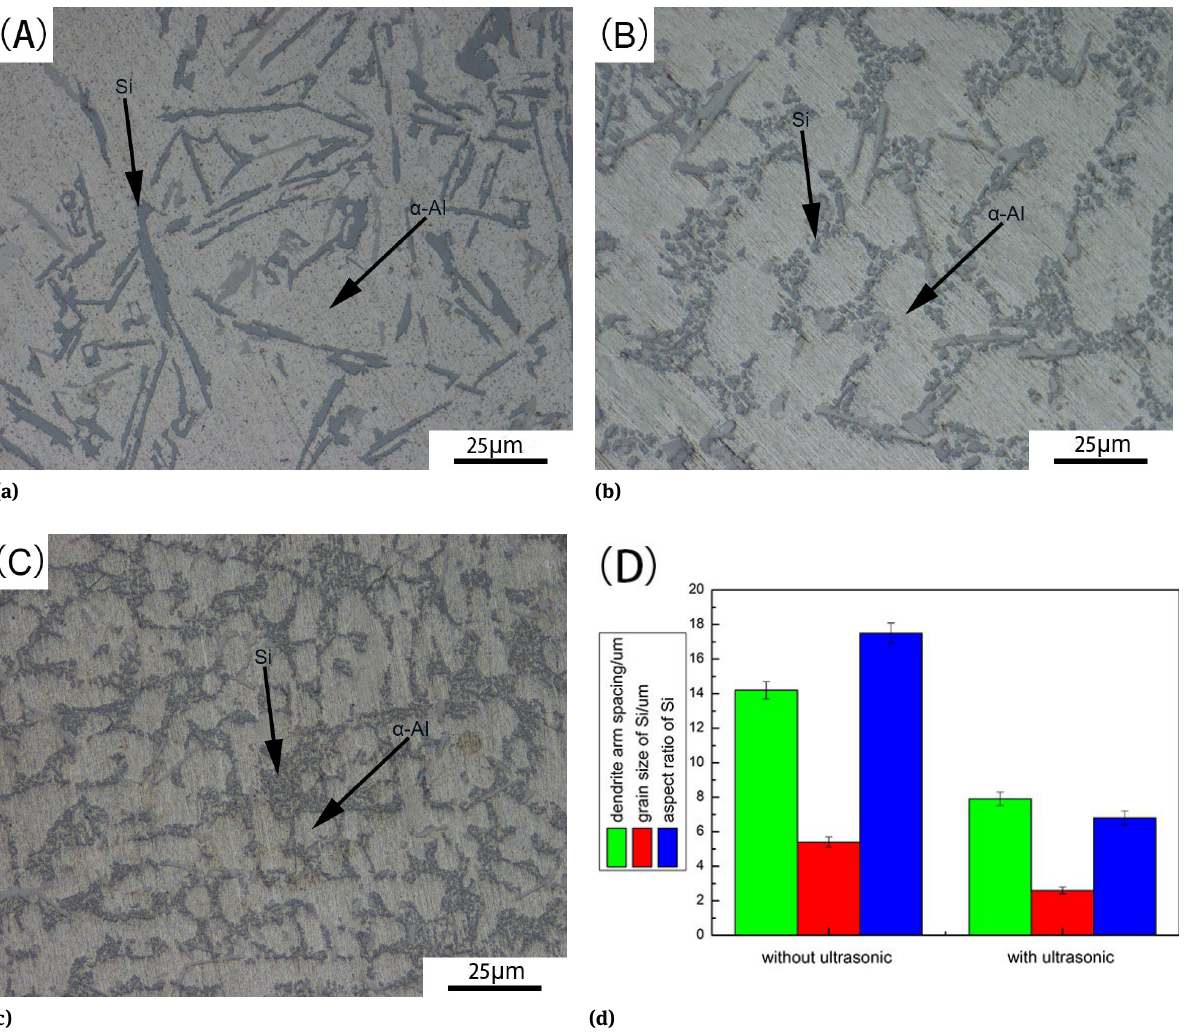
Figure 6: As-cast microstructures of (a) ADC12; (b) Al 3 Ti/ADC12(without ultrasonic); (c) Al 3 Ti/ADC12(with ultrasonic); (d) quantitative analy-